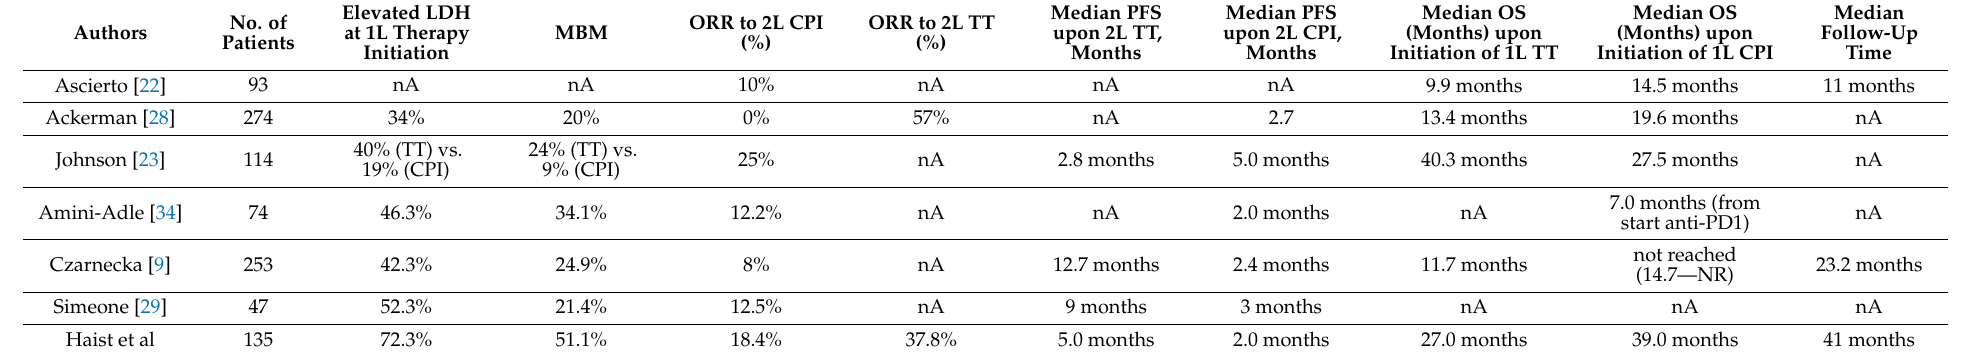
Table 5. Comparison of outcomes reported in different retrospective trials for patients with BRAF-mutant stage IV melanoma stratified by treatment